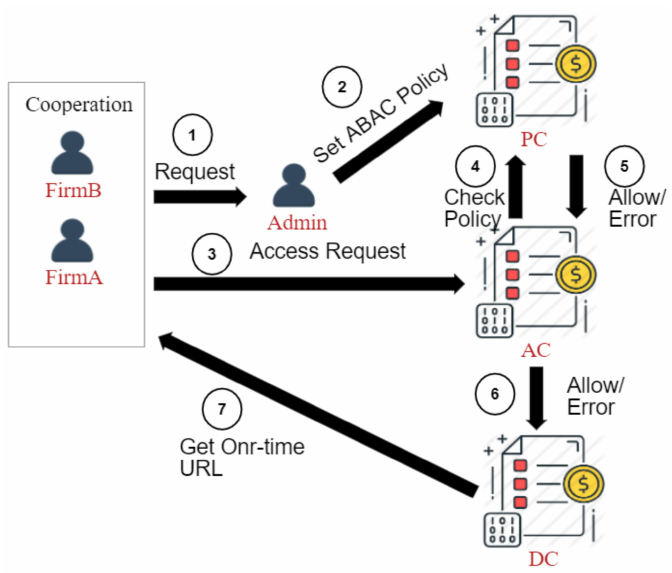
Figure 7. Vertical Strategic Alliances Relationship